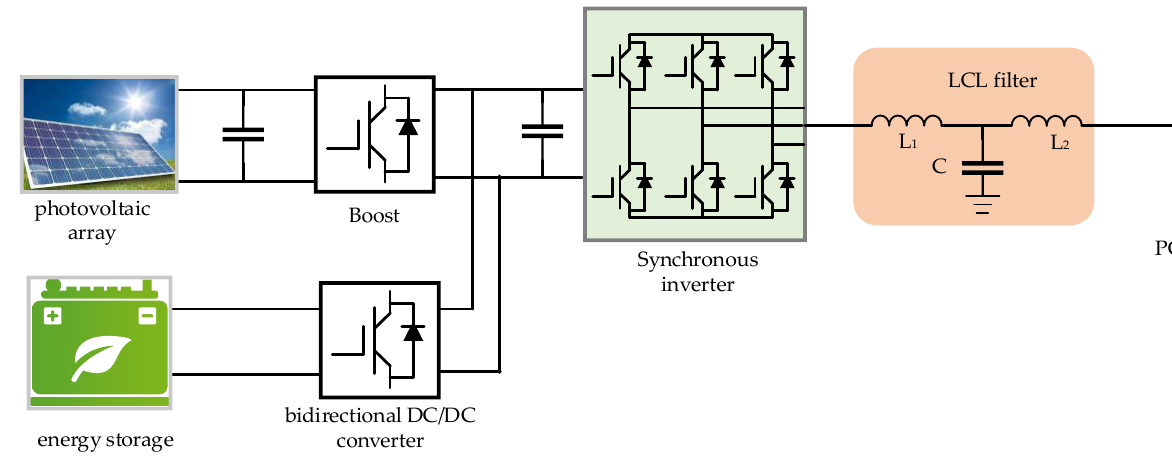
Figure 17. Applications of VSG in power systems.